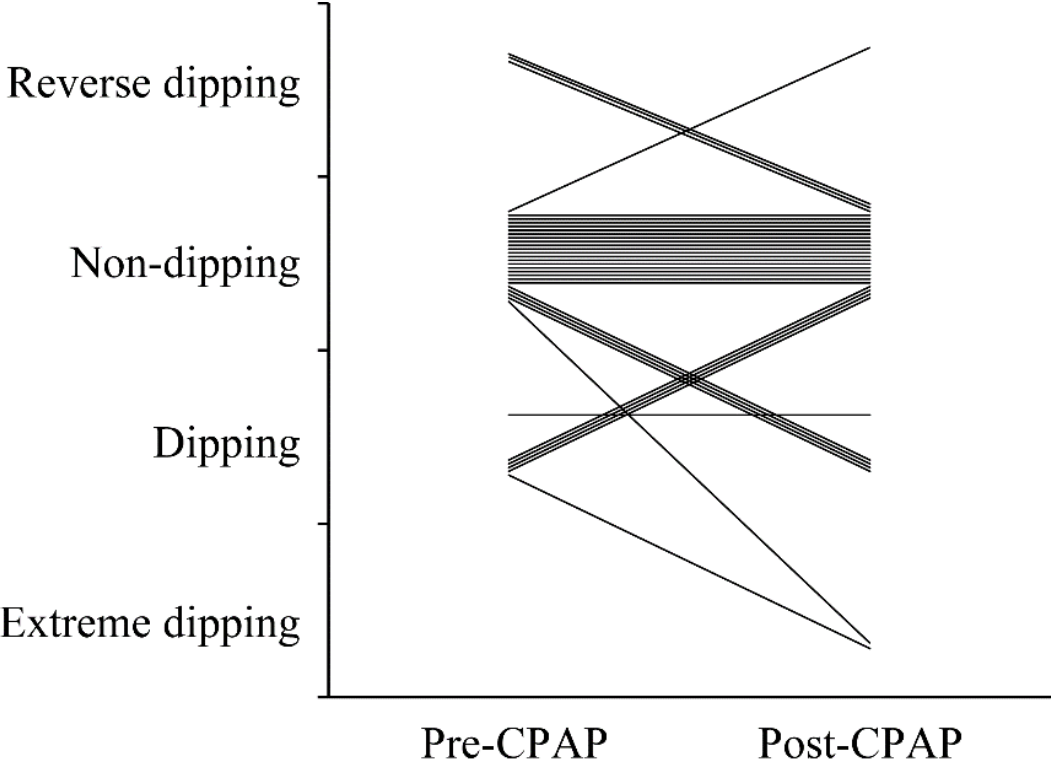
Figure 3. Changes in nocturnal blood pressure fluctuation patterns pre- and post-CPAP therapy. CPAP, continuous positive airway pressure.